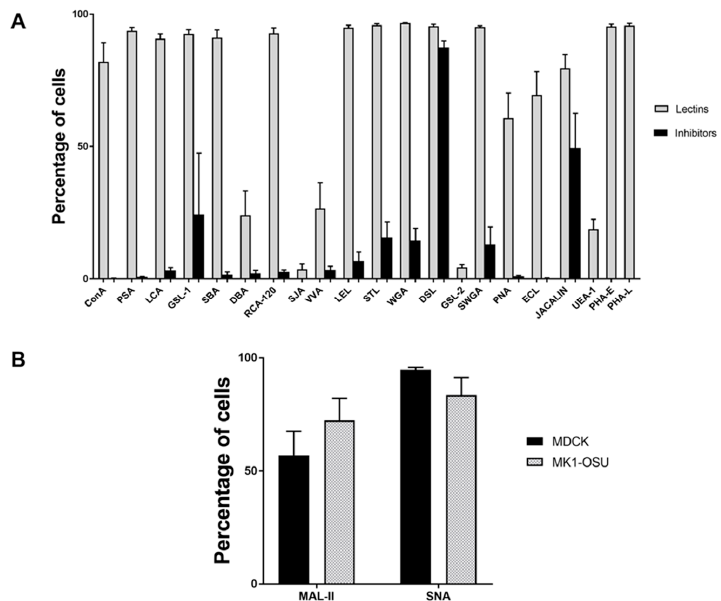
Figure 2. Lectin binding profile of MK1-OSU cells. ( A ) MK1-OSU cells were incubated with biotinylated lectins and were stained using streptavidin-FITC. Samples were analyzed using a FACSCalibur flow cytometer. Values represent the average for three to five independent experiments ± SE. ( B ) Differential expression of sialic acid receptors for influenza A virus in MK1-OSU and MDCK cells. Both MK1-OSU and MDCK cells were incubated with biotinylated lectins binding to Sial2-3Gal (MAL-II) and Sial2-6Gal (SNA) and were stained using streptavidin-FITC. Samples were analyzed using a FACSCalibur flow cytometer. Values represent the average for four experiments ±